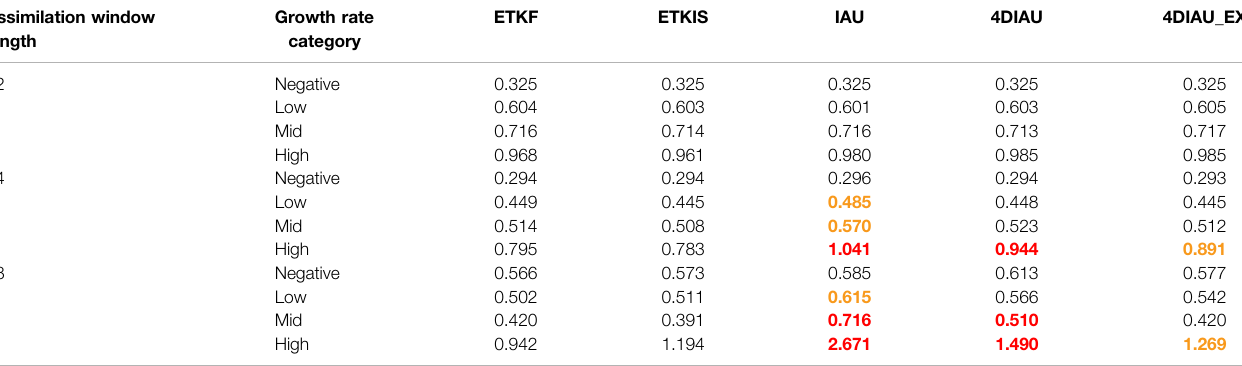
TABLE 1 | Mean RMSE of the of fl ine cycling experiments from different update algorithms. RMSE is calculated withthe analysismean at the end of the assimilation window. Numbers are highlighted if they are signi fi cantly higher (lower) than the ETKF RMSE. According to the t test, warm color indicates an RMSE signi fi cantly higher than the ETKF one. Darker and lighter color denote higher and medium con fi dence, corresponding to a level of 95 and 80%, respectively. Assimilation window length